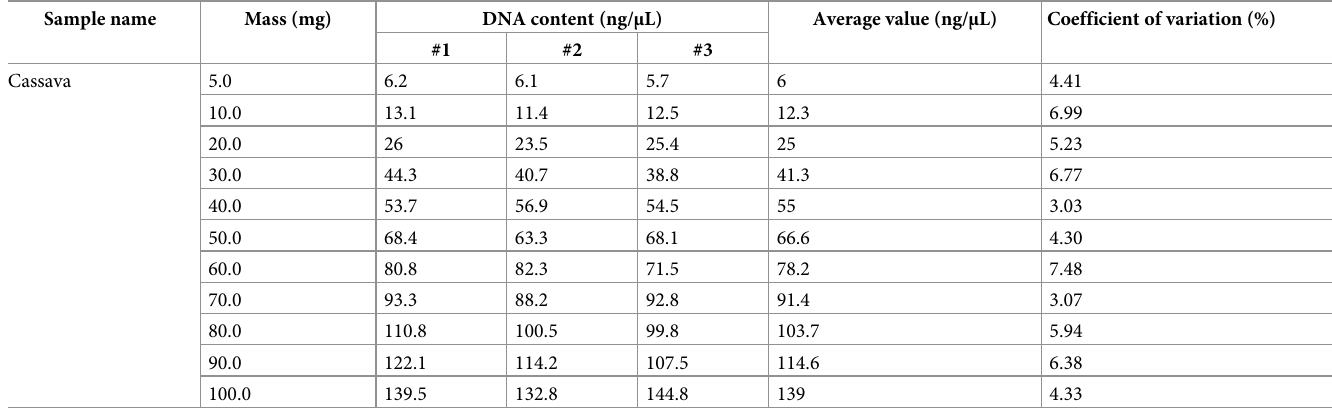
Table 3. Cassava DNA extraction results.